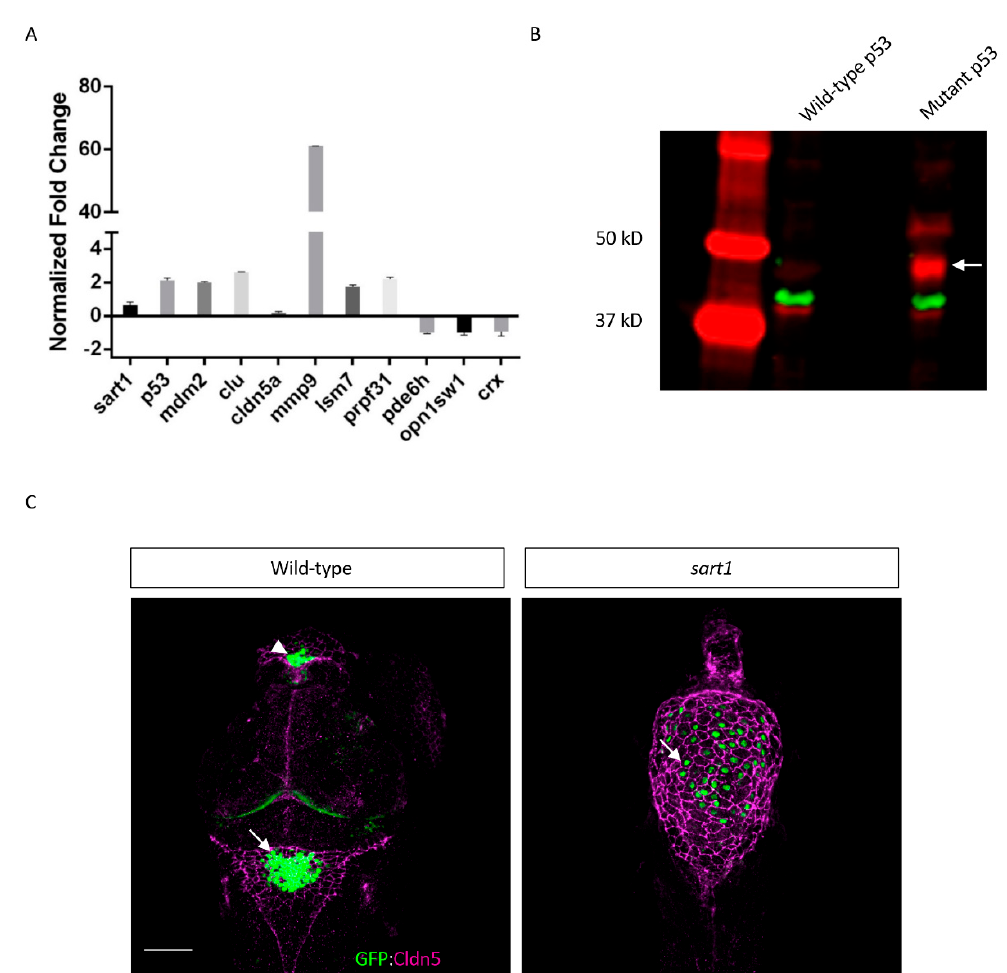
Figure 8. Multiple genes are upregulated or downregulated in cp27.5 mutants along with abnormal expression of p53 and claudin 5 proteins. ( A ) RNA-Seq analysis was confirmed using qRT-PCR. Fold changes were normalized to β -actin which was set to zero. Positive values represent upregulated expression while negative values represent a downregulation of gene expression. The majority of genes are upregulated including sart1 , apoptotic genes ( tp53 , mdm2 , clu ), tight junctions ( cldn5a ), extracellular matrix enzymes ( mmp9 ), and spliceosome factors ( lsm7 , prpf31 ), while vision-related genes are downregulated ( pde6h , opn1sw1 , crx ). Error bars are expressed as mean ± SE (standard error) for n = 3 from mutant samples. ( B ) Both cp27.5 wild-type and mutant express p53 with a protein size of 42 kDa (red). However, cp27.5 mutants also highly express a p53 protein that is absent in wild-type (arrow). Protein levels were normalized to β -actin (green). ( C ) Whole mount IHC was performed on cp27.5 wild-type and mutant larvae at 3 dpf. In wild-type, the dCP (arrowhead) and mCP (arrow) express GFP (green). Claudin 5 (purple) is localized to the surface vasculature and co-localizes with the CP epithelia (yellow). In mutant, the dCP is absent and the mCP consists of individual sporadic GFP positive cells (arrow). Claudin 5 is expressed throughout the brain ventricle and surrounds CP epithelia, but does not colocalize with the cells as seen in wild-type. Scale bar is 50 µm.